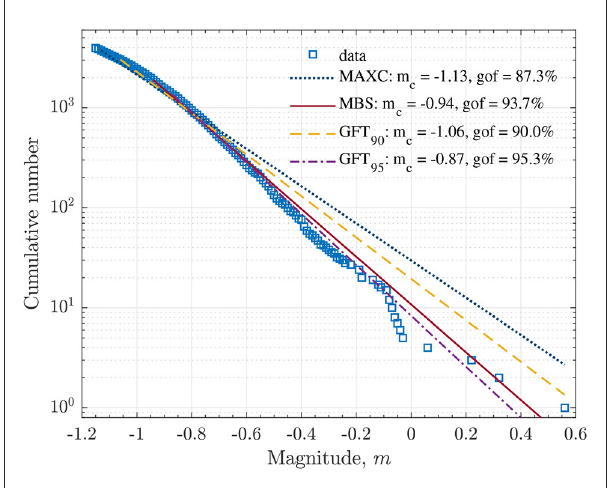
FIGURE3 The frequency-magnitude statistics for the mining-induced seismicity. The light blue open squares represent the cumulative number of events. The distribution was fit by the G-R relation (3) with the cutoff magnitude m min taken to be the completeness magnitude m c . Several fits correspond to different values of m c obtained from the application of: the MAXC (dotted blue line), MBS (solid red line), GFT (90% yellow dashed line), and GFT (95% purple doted-dashed line) methods. The estimated a and b -values with 95 % confidence intervals are given in Table 1.